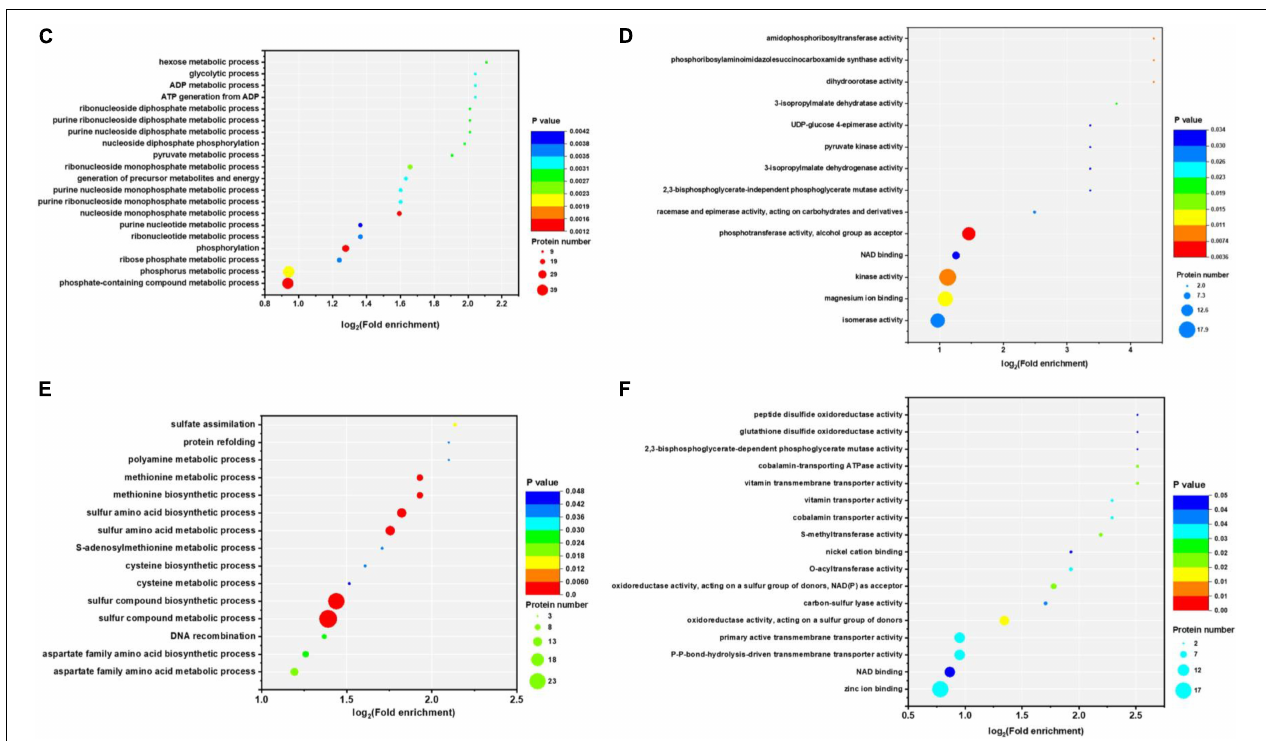
FIGURE 3 | Gene Ontology (GO) classification and enrichment analysis of G40 and G120–20 (+betaine). (A) GO classification of 3,284 proteins. The ordinate on the left is –log 10 (percent of proteins), and the label on the column is the number of proteins. (B) GO classification of 170-up and 291-down proteins. (C) The enrichment analysis of the BP (170-up proteins). (D) The enrichment analysis of the BP (291-down proteins). (E) The enrichment analysis of the MF (170-up proteins). (F) The enrichment analysis of the MF (291-down proteins). [The p -value (corrected) <